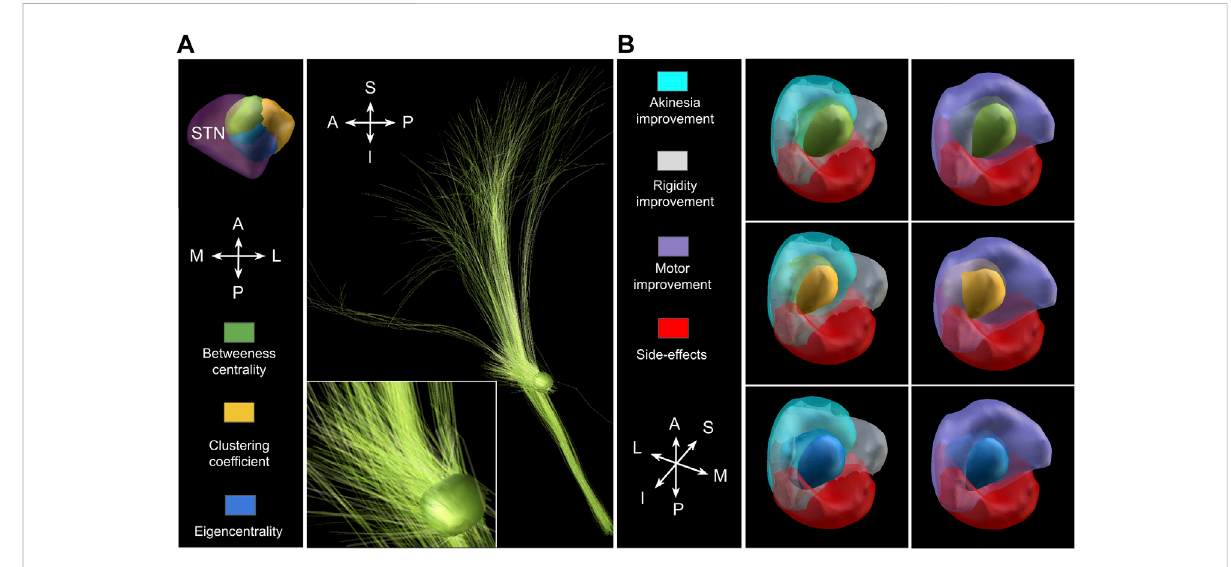
FIGURE 6 RecruitmentofneuraltissuebymonopolarSTN-DBSatthecentralitynodes. (A) :Allthree(overlapping)VTAsarelocatedinthedorsolateralSTN (left; green for between-centrality nodes, yellow for clustering coef fi cient, and blue eigencentrality) and predominantly recruit motor pallidosubthalamic projections, the hyperdirect pathway from the primary motor cortex (upper and lower extremities), as well as its branch descendingfrom thedorso-lateralprefrontalcortex(right).Notethat thelatter wasnotusedto construct thenetworkmodel.Fortheparticular stimulation protocol (2 mA ), no corticofugal fi bers are recruited according to the computational model. (B) : The VTAs(green for between-centrality nodes, yellow for clustering coef fi cient, and blue eigencentrality) overlap with target areas, whose stimulation is clinically proven to improve motor symptoms,especiallyakinesiaDembeketal.[25].Whileanoverlapalsowithregionsproducingpossibleside-effectsexists,thisoverlapissigni fi cantly smaller (note that the regions delineated in Dembek et al. [25] overlap as